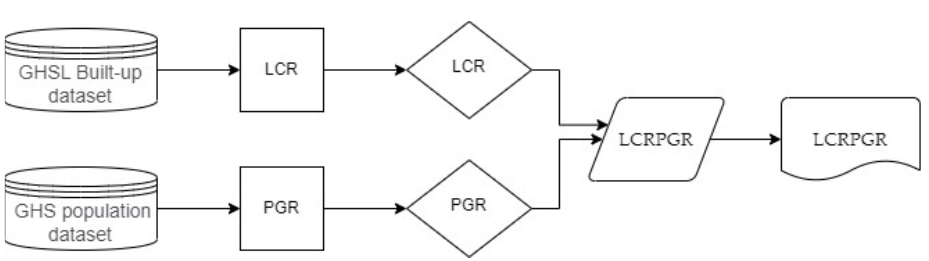
Figure 2. Workflow for calculating the LCRPGR indicator. LCR indicates the intensity of change of the new built-up space over a period of time in a certain spatial location (Equation (2)).